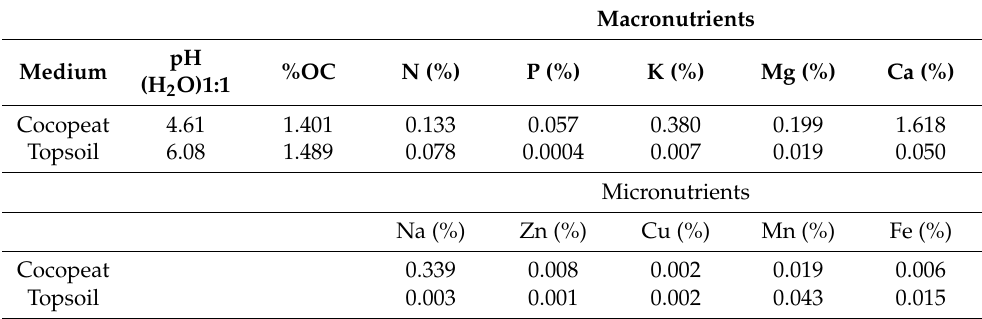
Table 1. Chemical attributes of the cocopeat and topsoil growth